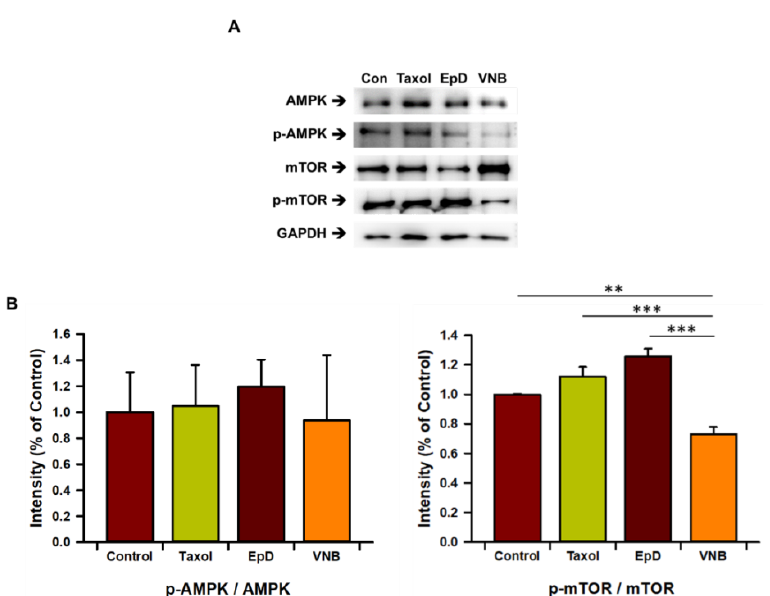
Figure 6. Protein expression of AMPK and mTOR in microtubule stabilizer- and microtubule disturber-treated cells. ( A ) Blots of AMPK, pAMPK, mTOR, and pmTOR in control, Taxol-treated, EpD-treated, and VNB-treated cells. ( B ) Graphs of the band intensities of pAMPK/AMPK and pmTOR/mTOR in control, Taxol-treated, EpD-treated, and VNB-treated cells. The data are presented as means ± SEM of three replicates. Significant differences are indicated by asterisks (** p < 0.01, *** p < 0.001).